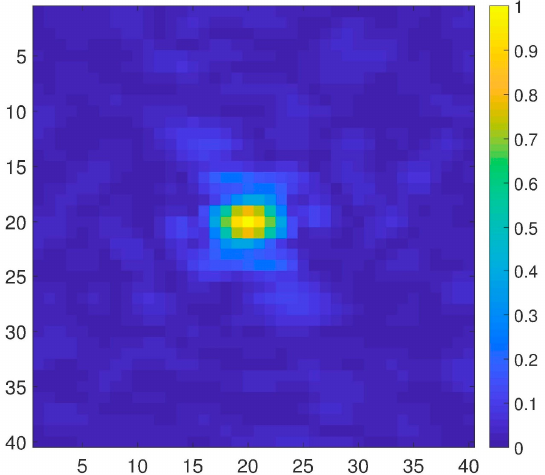
Figure 4. An X-ray diffraction pattern of ADK [ 26 ].